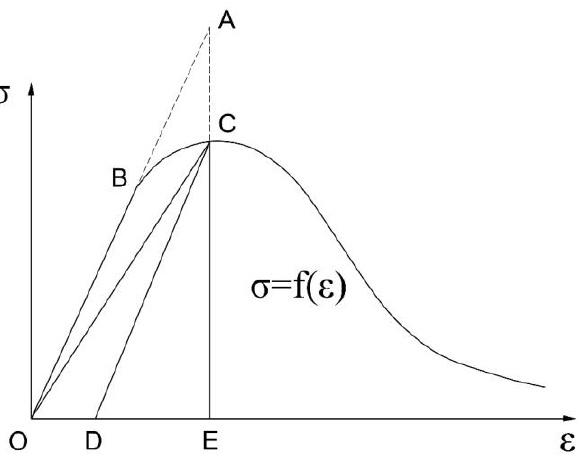
Figure 7. The stress–strain curve based on the concrete damage theory presented by Najar [28]. In this case,